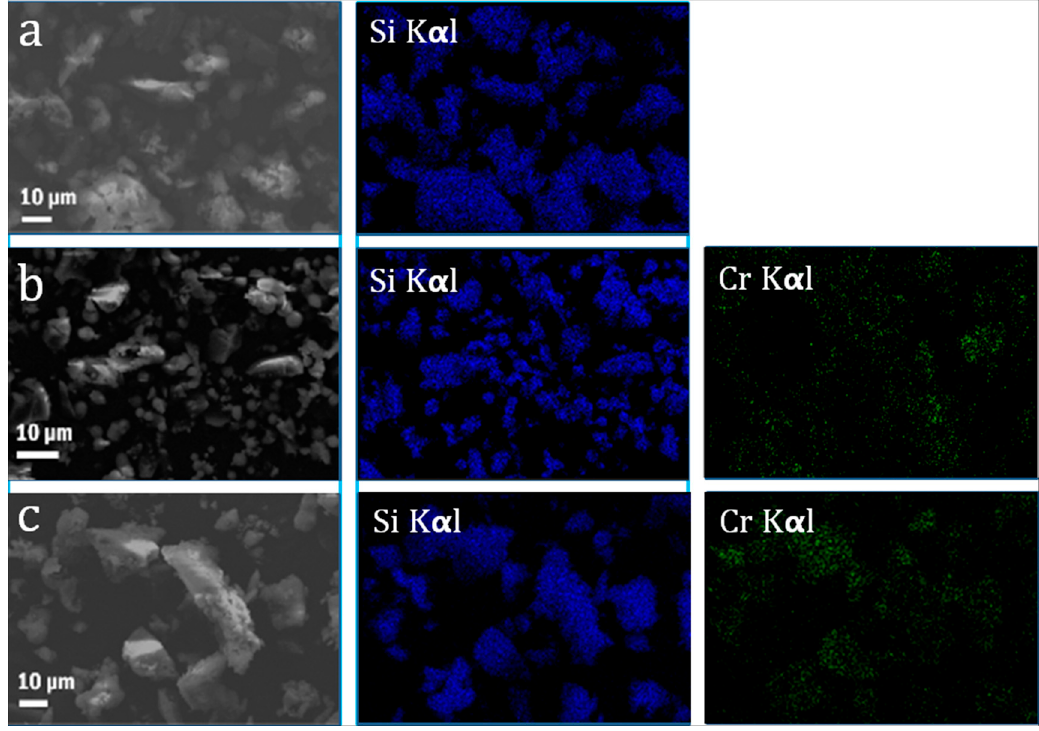
Figure 5. SEM images and EDX elemental mapping (chromium (green); silicon (blue)) of Figure5. SEMimagesandEDXelementalmapping(chromium(green); silicon(blue))ofCr(y) / Cr(y)/LPMS-130 prepared with different chromium loadings: ( a ) 0, ( b ) 4, and ( c ) 8 wt %.